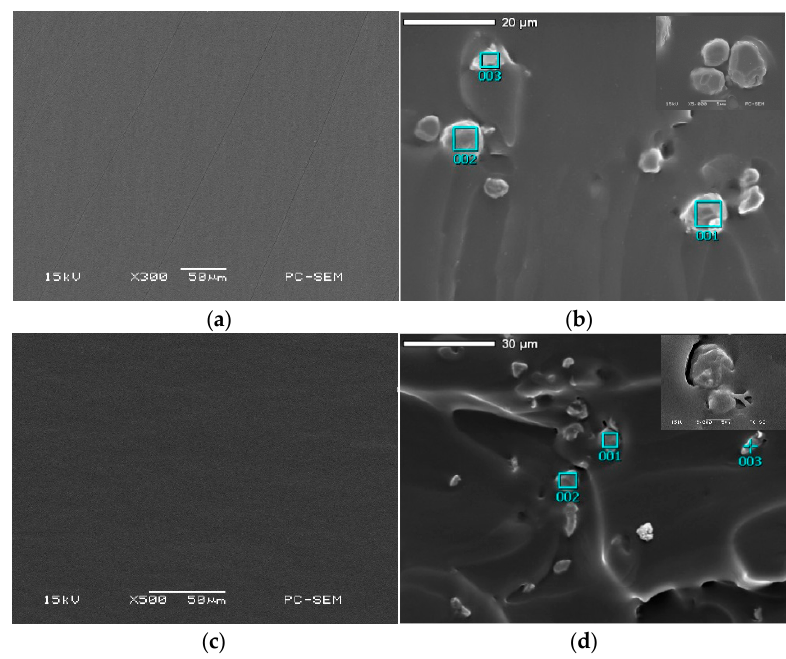
Figure 17. Fracture morphology of test samples: ( a ) 0% and ( b ) 10% before ageing; ( c ) 0% and ( d ) 10% after ageing.